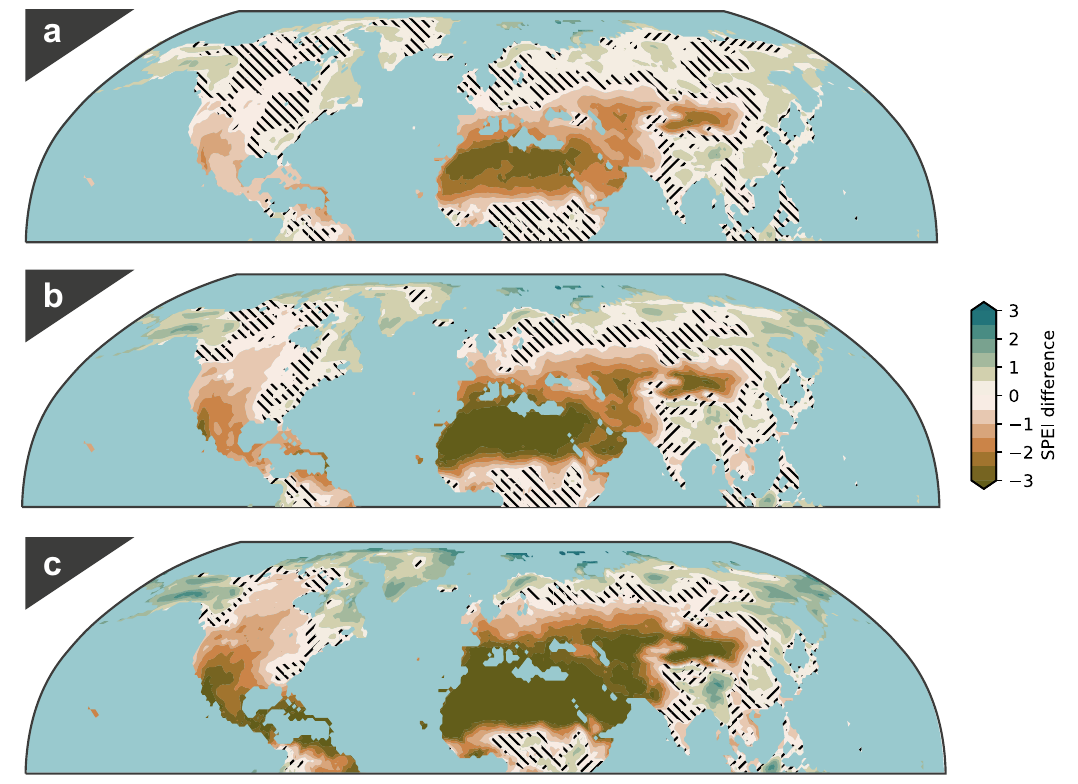
Fig. 6 Changes to summer drought conditions under SSP1-2.6, SSP2-4.5 and SSP5-8.5. a – c Averaged anomalies of summer droughts under SSP1-2.6 ( a ) and SSP2-4.5 ( b ) and SSP5-8.5 ( c ) in the Northern Hemisphere for the period 2071 – 2100 relative to the baseline period of 1971 – 2000. The hatched areas in all three sub fi gures indicate areas with insigni fi cant changes according to the two-sided Student ’ s t test ( p <